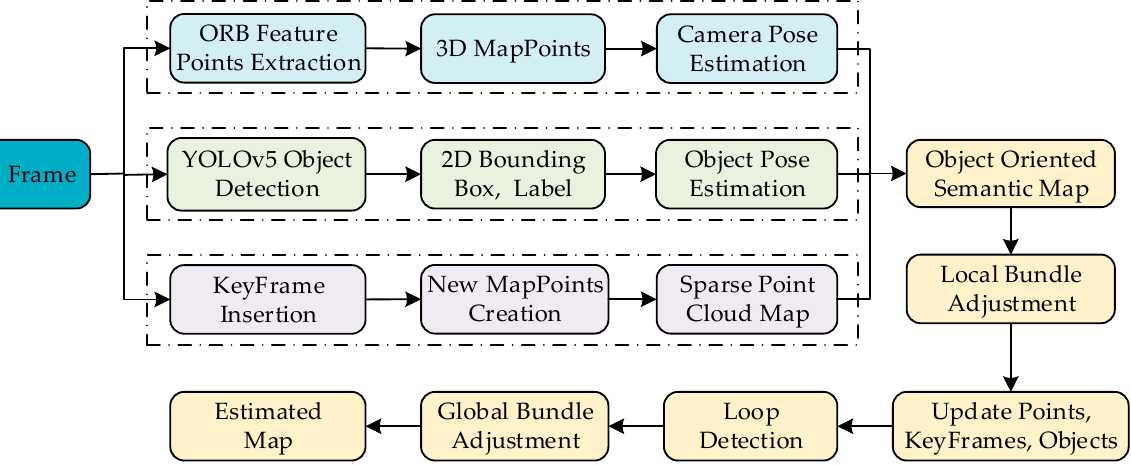
Figure 10. Object-oriented SLAM system framework.